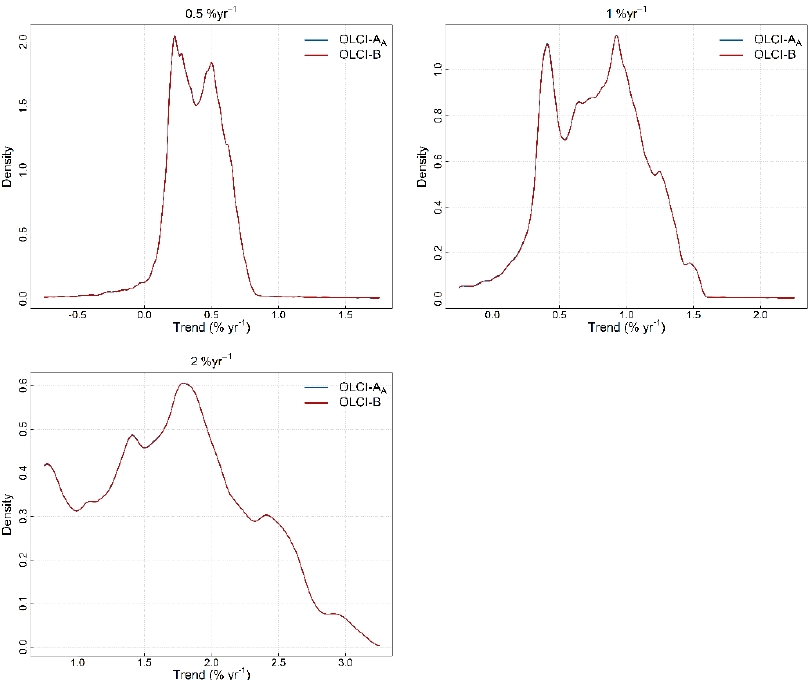
Figure A2. Histograms of all chl- a trends estimated in all 1 ◦ grid cells and all bootstraps for OLCI-A-Aligned and OLCI-B. This shows that OLCI-A-Aligned and OLCI-B both show very similar distributions of chl- a trends, except that OLCI-A-Aligned has slightly smaller variance, which applies to all input trends.